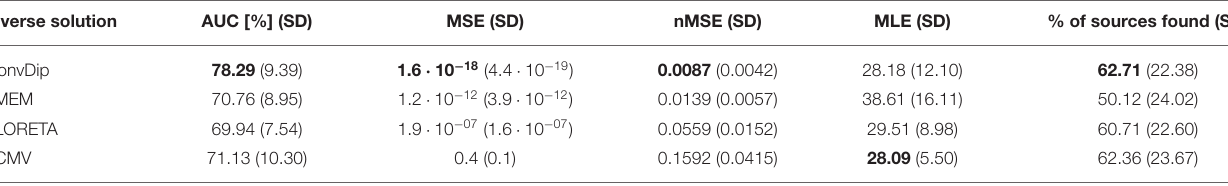
TABLE 2 | Comparison of inverse algorithm performance for samples containing multiple source